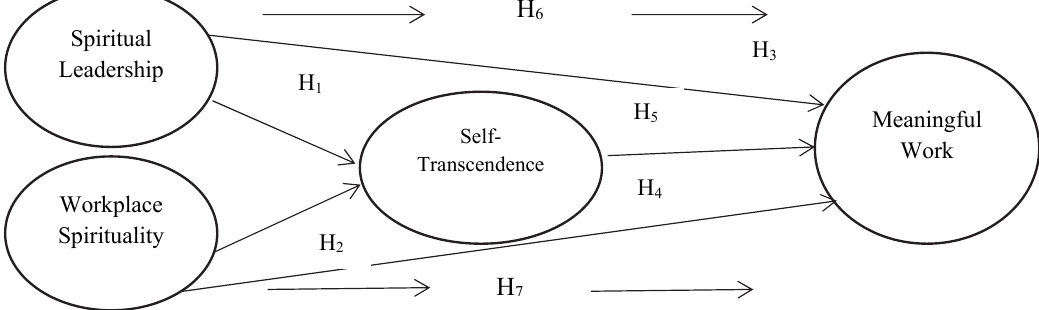
Fig. 1. Research Framework